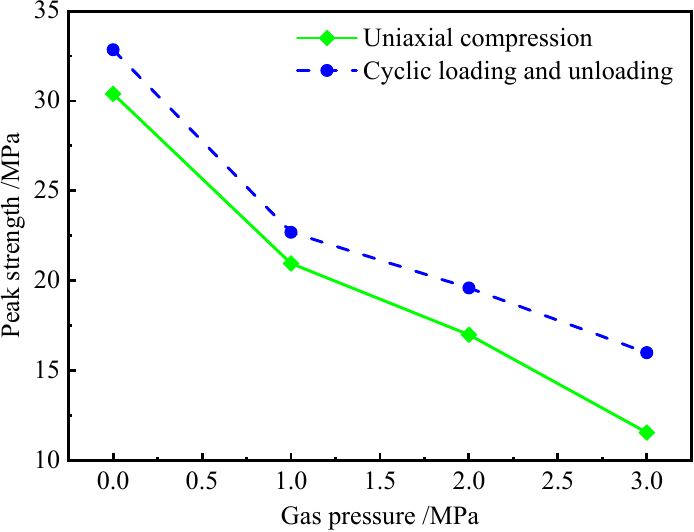
Figure 5. Evolution of peak strength with gas pressure under different loading schemes.